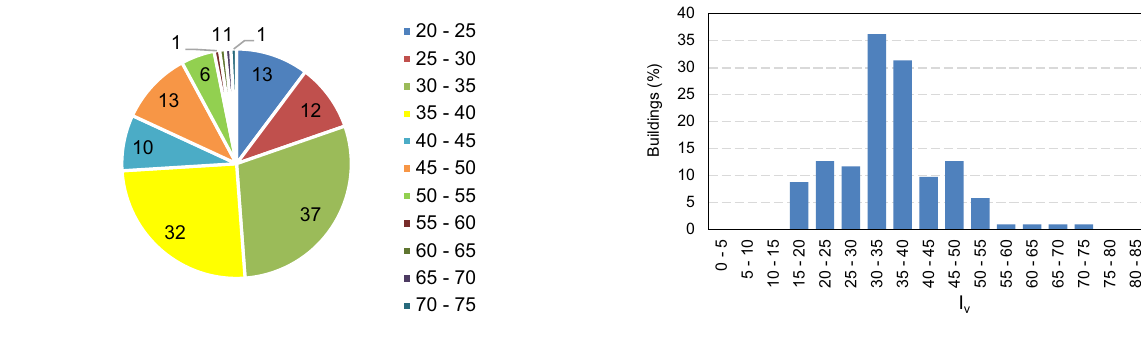
Fig. 6 Vulnerability Index as per GNDT method—Percentage of